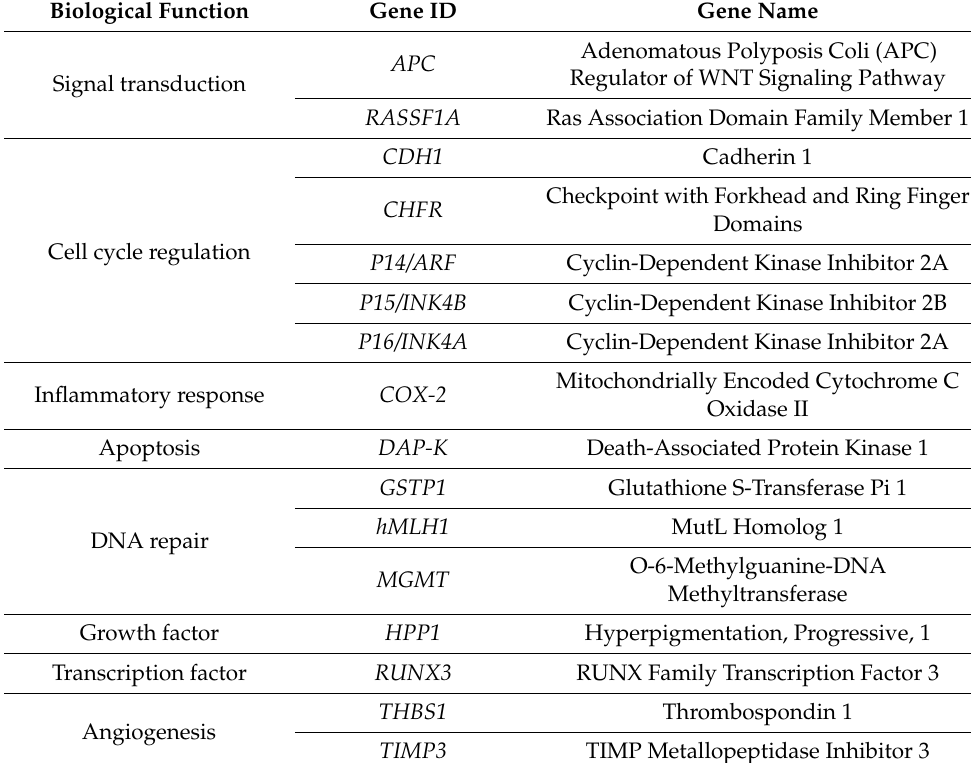
Table 1. Genes involved in the epigenetic control of expression levels in Hp